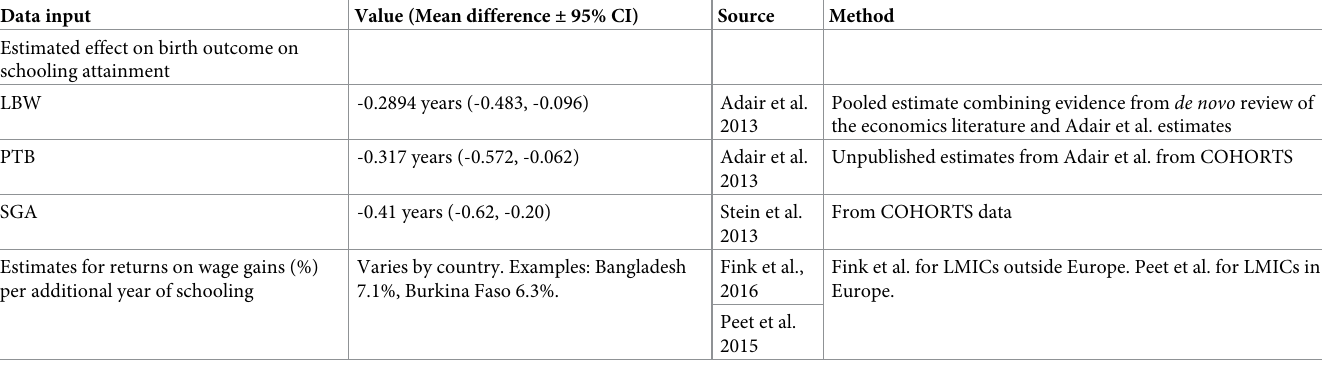
Table 1. Effect size sources for model